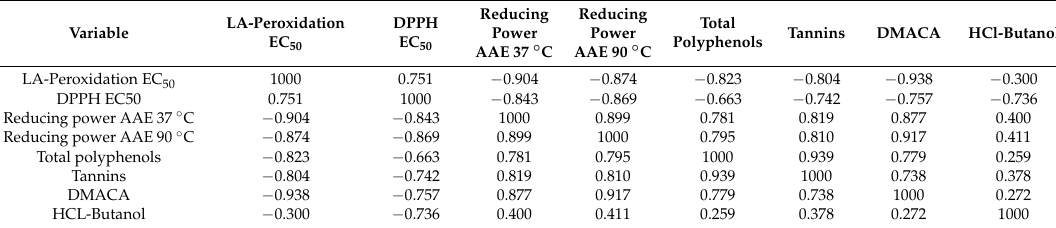
Table 4. Spearman Rank Order Correlation. Marked correlations are significant at p <